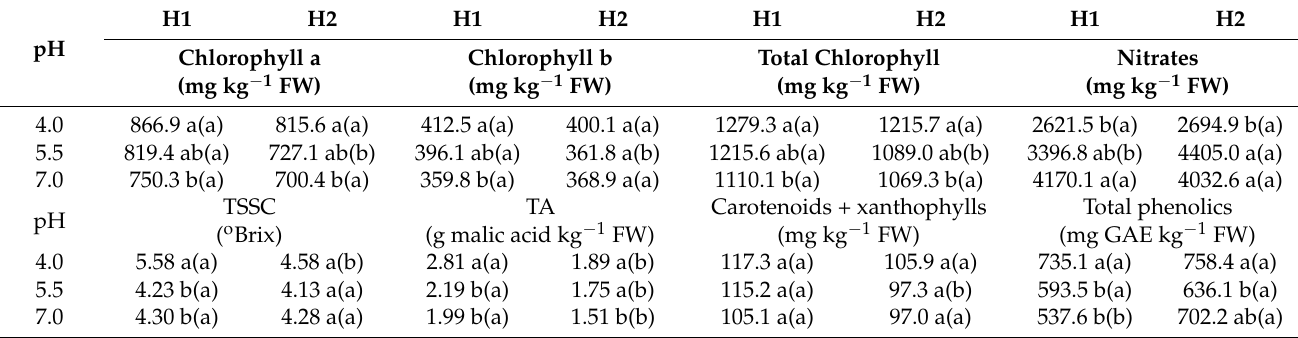
Means in columns followed by the same letter do not differ significantly ( p ≤ 0.05, L.S.D. test). Means in the same row followed by the same letter in parenthesis do not differ significantly ( p ≤ 0.05, T -test). FW: fresh